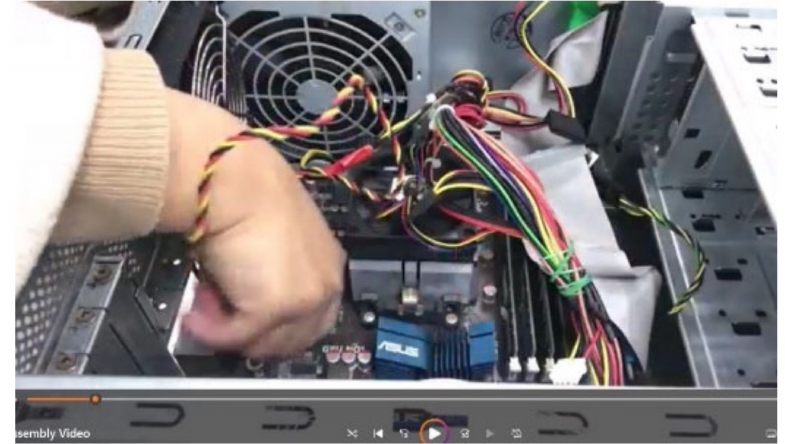
Figure 5. Video display showing how to unplug the cable of the fan connected to the motherboard in the disassembly task (step 3).